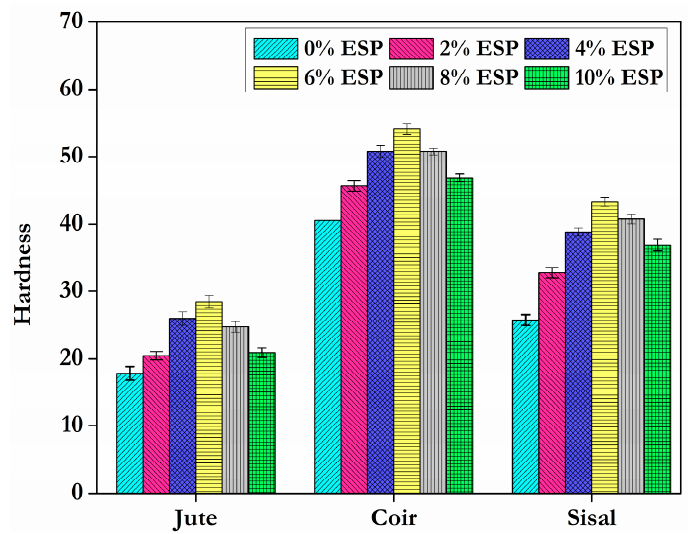
Figure 10. Hardness of different fibres with varying proportion of ESP.